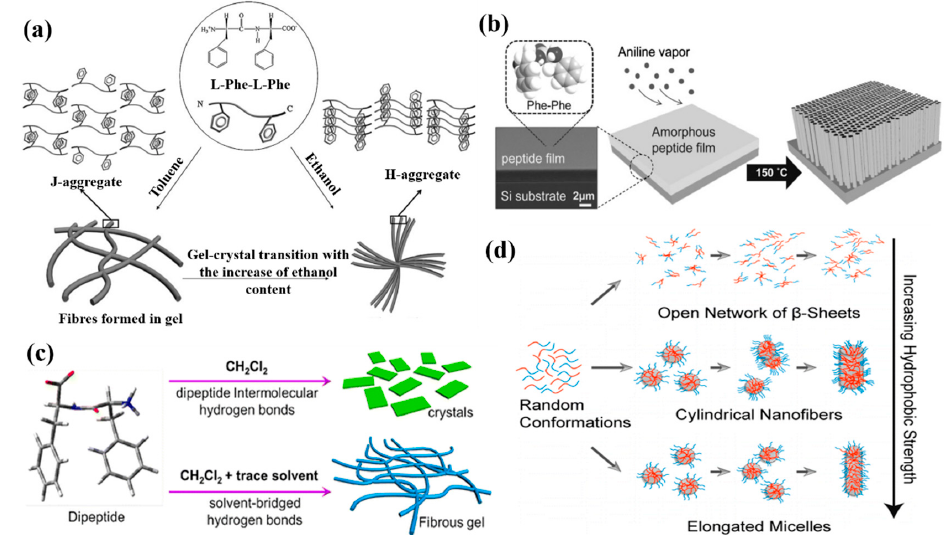
Figure 10. Effects of organic solvents on biomolecular self-assembly: ( a ) The structural transition of FF nanofibers in mixed organic solvents. Reprinted with permission from [136]. Copyright 2010